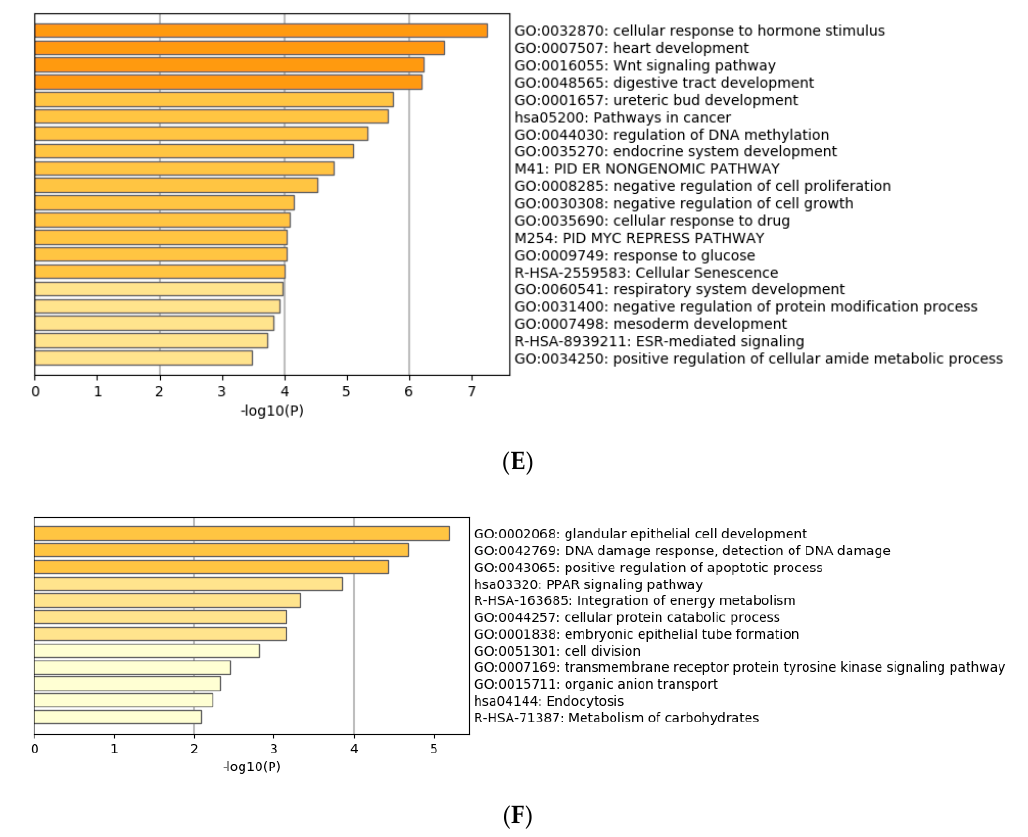
Figure 5. Gene prediction analysis. MiRNA sequences up and downregulated in the BEAS-2B sample exposed to OMVs of K. pneumoniae ATCC 10031 ( A , B ), MS K. pneumoniae ( C , D ) and KPC-producing K. pneumoniae ( E , F ).